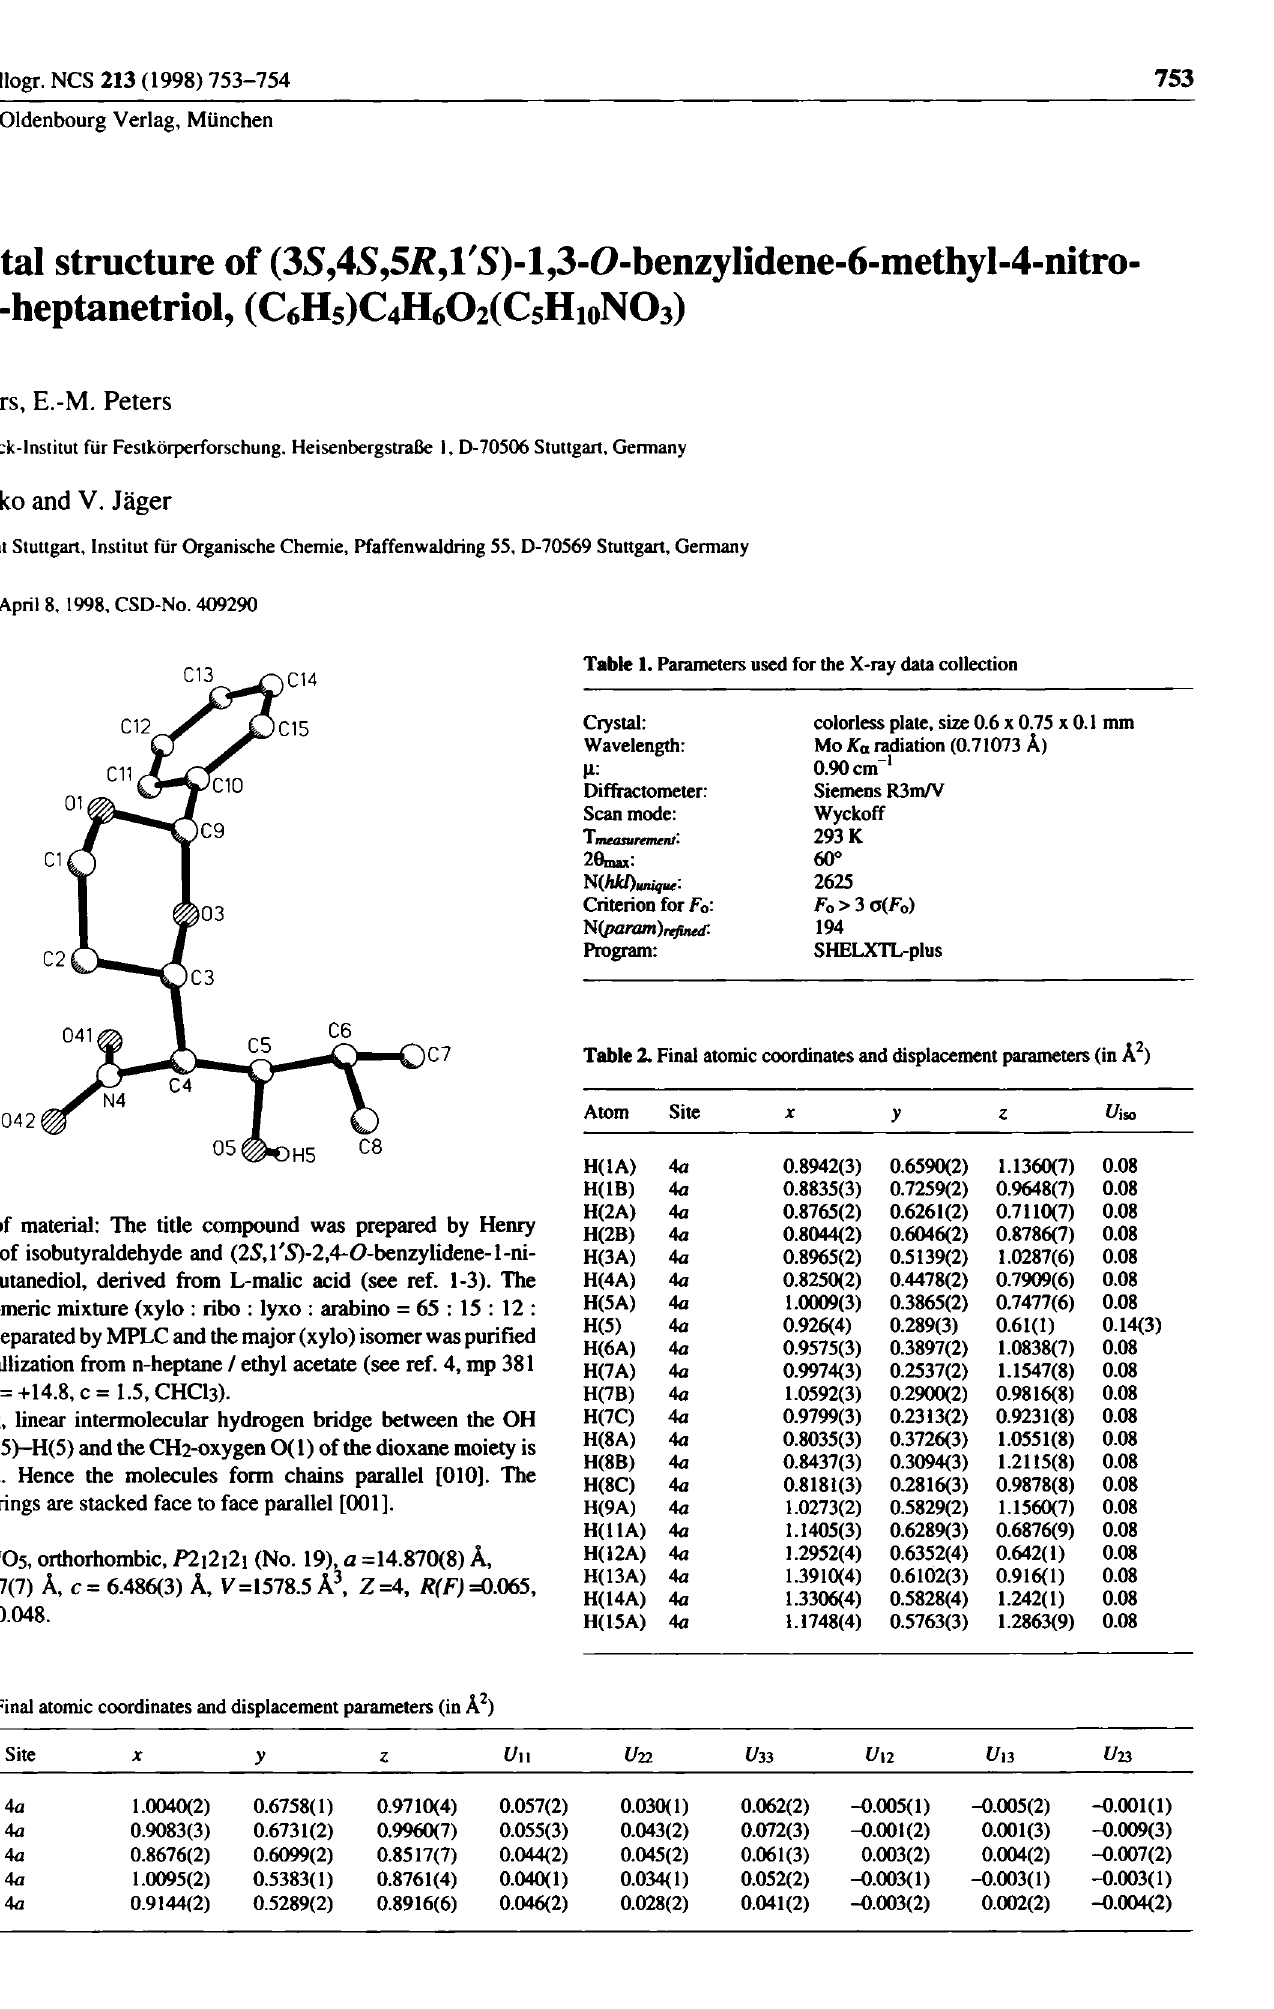
Table 3. Final atomic coordinates and displacement parameters (in Â^)